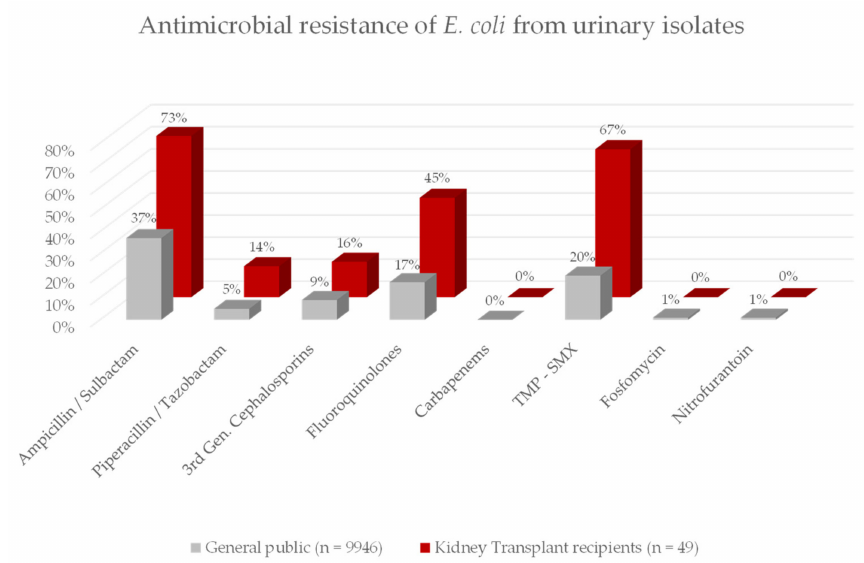
Figure 1. This figure shows the antimicrobial resistance to commonly used antibiotics of E. coli in our Kidney Transplant (KT) cohort compared to the local general public. Resistance to Ampicillin / Sulbactam, fluoroquinolones and Trimethoprime-Sulfamethoxazole (TMP–SMX) is substantially higher in the Kidney Transplant cohort.